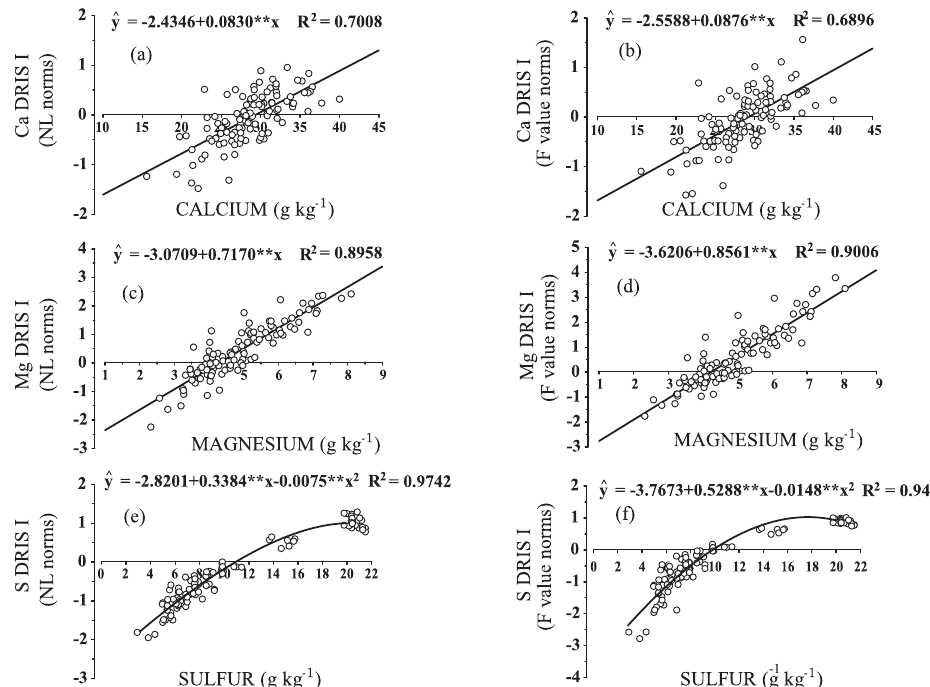
figure 2. Relationship between the macronutrient levels (reference and non-reference population) and their respective DRis indices (DRis i), generated by the norms based on the criterion of natural log transformation (nl) (a, c and e) and the norms defined by f value (b, d and f). ** p < 0.01.